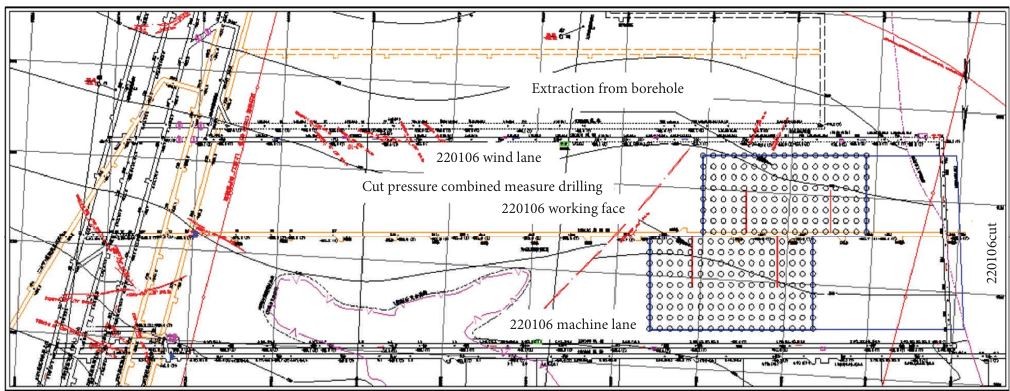
Figure 12: Cut pressure combined measures plan.